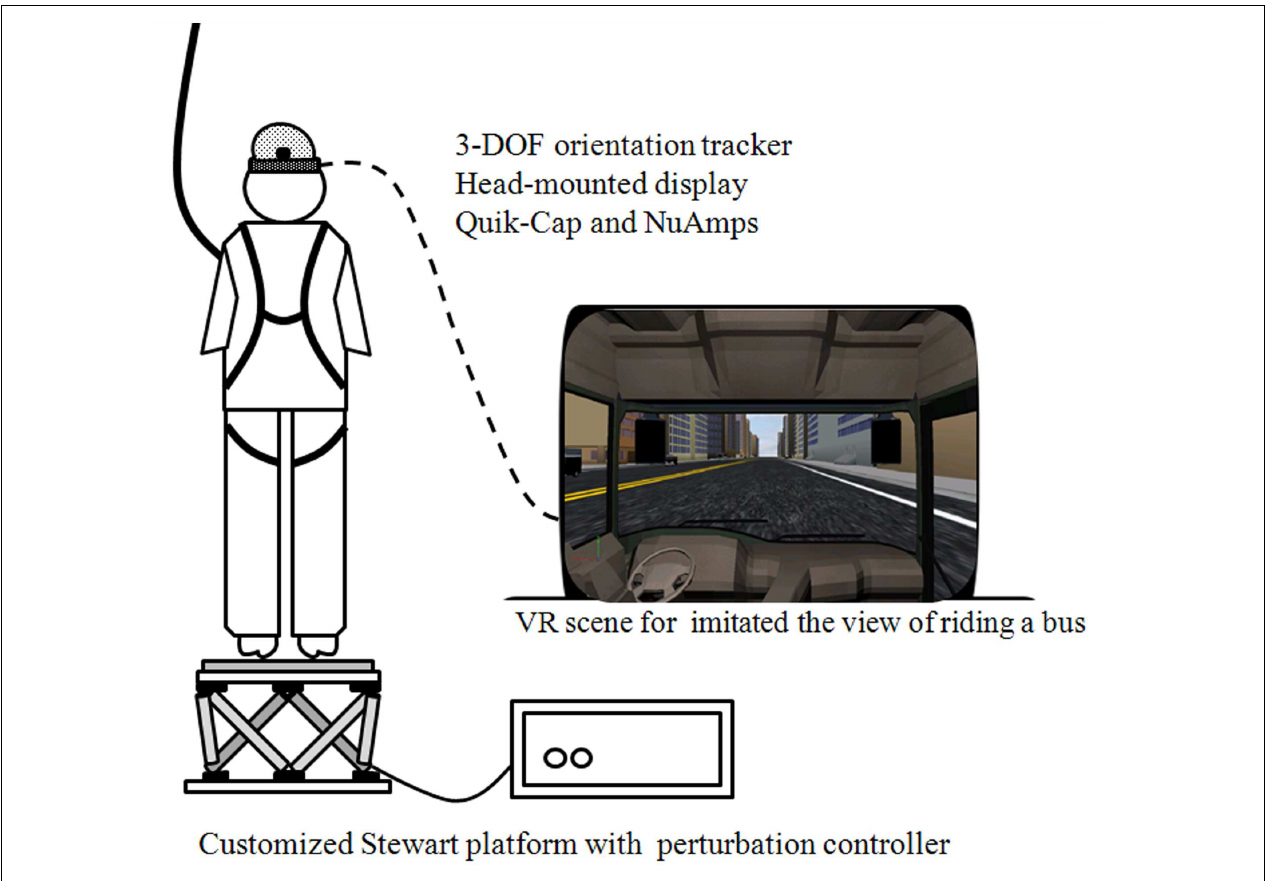
FIGURE 1 | Instrument and virtual reality set-up. Each participant was required to stand barefoot on a Stewart platform that induced continuous perturbed motions, and was either synchronized with or without the VR-based scenery which represented the view of riding on the passenger bus. The electroencephalography signals were also recorded synchronously and a full-body harness was worn to prevent falling.